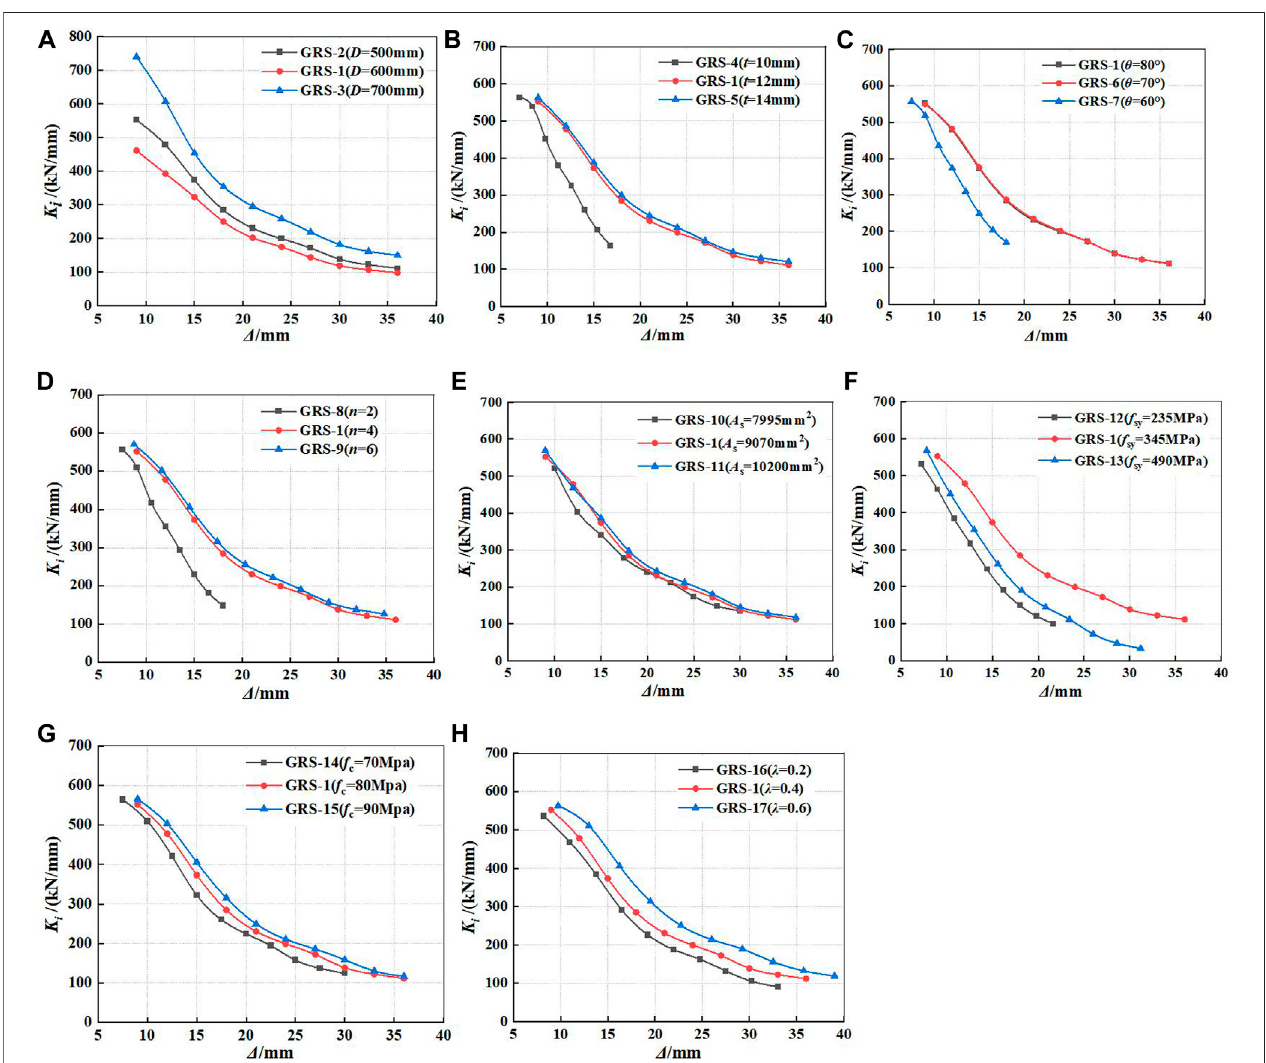
FIGURE 12 | Comparisons of secant stiffness degradations for GRS columns: (A) different diameters of GFRP tube; (B) different thicknesses of GFRP tube; (C) different fi ber winding angles; (D) different numbers of fi ber winding layers; (E) different areas of encased steel; (F) different strengths of encased steel; (G) different compressive strengths of RPC; and (H) different axial compression